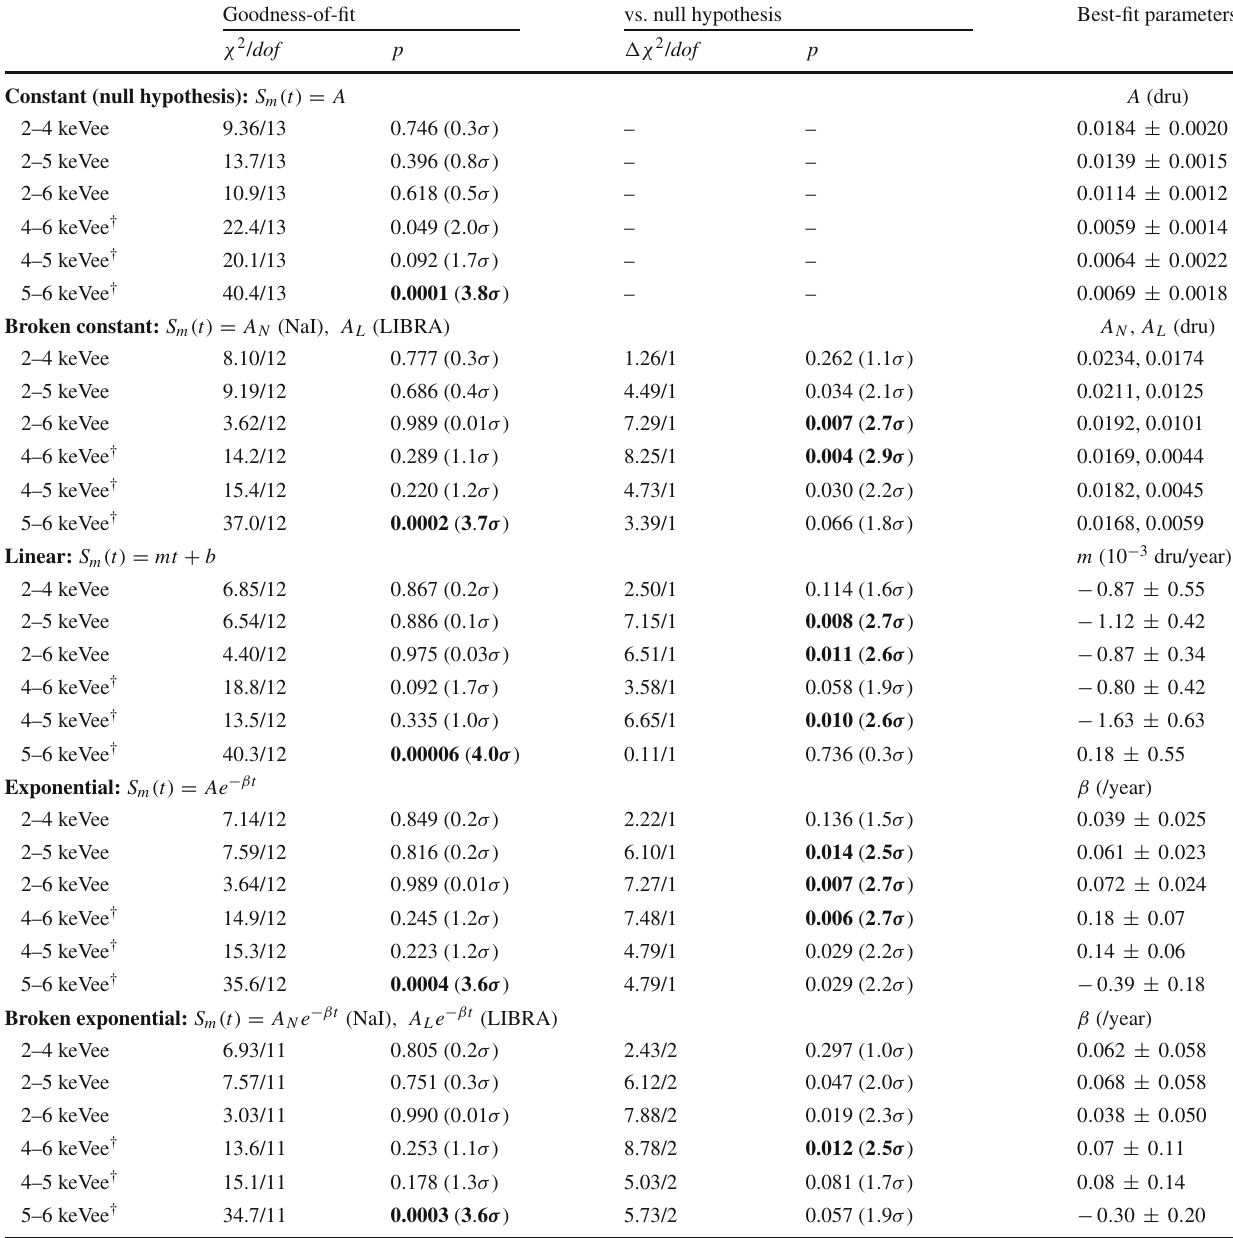
Table 6 Fits of the per-cycle DAMA modulation amplitude data of p -value for a hypothesis test where the conventional constant modula- Table 3 and Table 5. The minimum χ 2 and corresponding p -value for a tion amplitude is taken as the null hypothesis. Best-fit parameters are χ 2 goodness-of-fit are shown, followed by the (cid:7)χ 2 and corresponding shown in the final column; parameters not shown are profiled over Goodness-of-fit vs. null hypothesis Best-fit